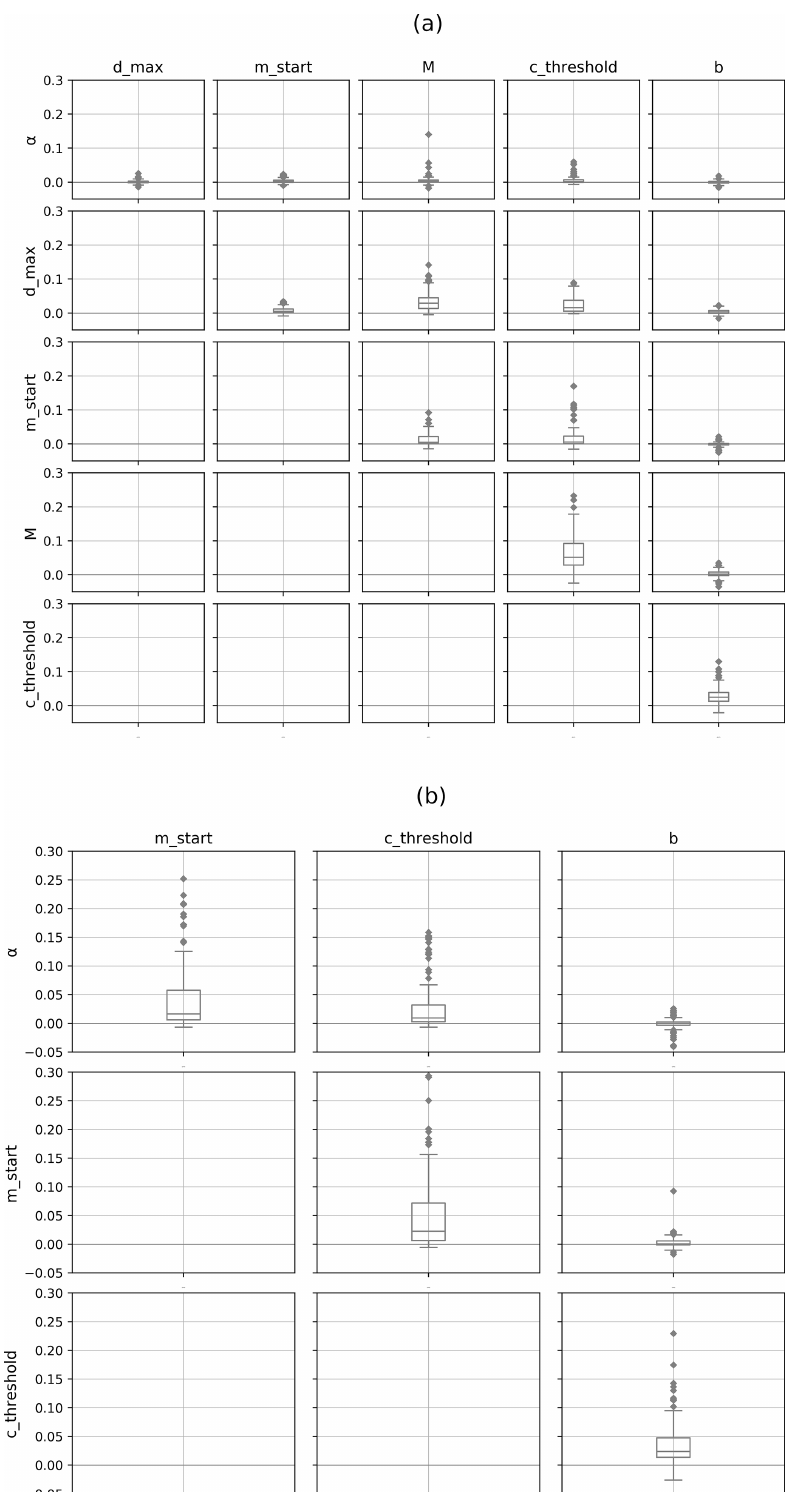
Figure 10. Distribution of second-order Sobol indices ( S 2) in the modeled reservoirs for each pair of parameters: (a) in irrigation and (b) in non-irrigation